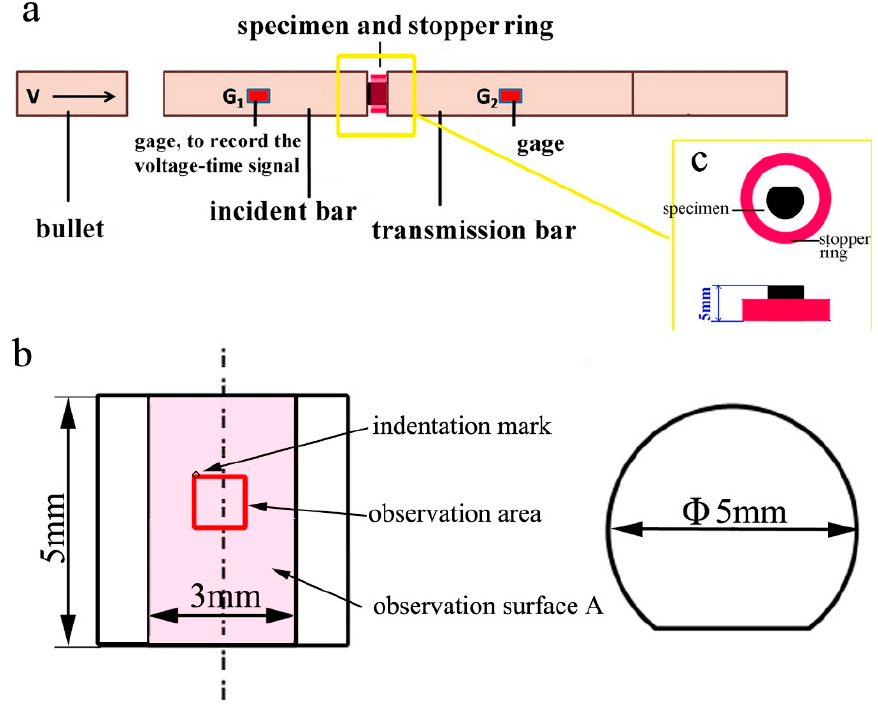
Figure 2. Schematic diagram of ( a ) SHPB device; ( b ) specimen; ( c ) stopper ring. The specimen was carefully designed for the quasi in situ microstructure observation. First, a cylinder with 5 mm in diameter and 5 mm in height was exacted from the inner part of the annealed plate mentioned above to avoid the surface oxide layer. Then a flat plane with a dimension of 3 mm × 5 mm (named Surface A) was milled at the side of this cylinder, which was specifically designed for the observation of microstructure evolution, as shown in Figure 2b. The surface was ground using SiC sand paper and electrolytic polished (volume ratio of perchloric acid: acetic acid equals 5:95) at 65 V. In order to analyze the slip lines, the sample surface was not etched, and the electrolytically polished samples were applied to SEM and EBSD. After the surface preparation, a small reference mark (width about 20 µ m) was made on Surface A using a diamond cone indenter to help locate the observation site after each stop of the dynamic deformation. Then a 1 mm × 1 mm observation area was selected just near the reference mark (the red rectangle area in Figure 2b. This observation site was far more than 0.5 mm away from the sample